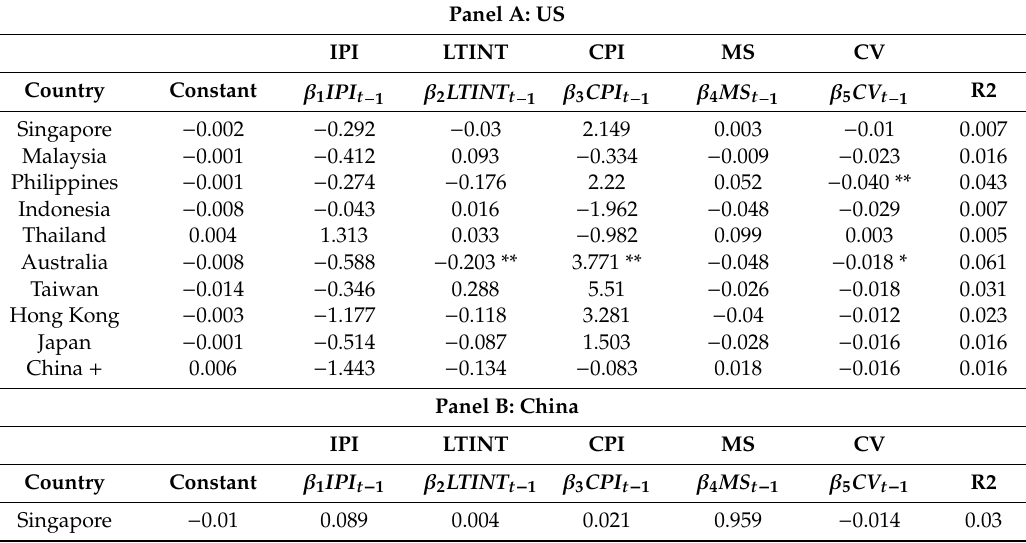
Table 4. Regression of the macroeconomic variables of the US and CH on APAC’s monthly real estate excess returns: January 1988–April 2017 4